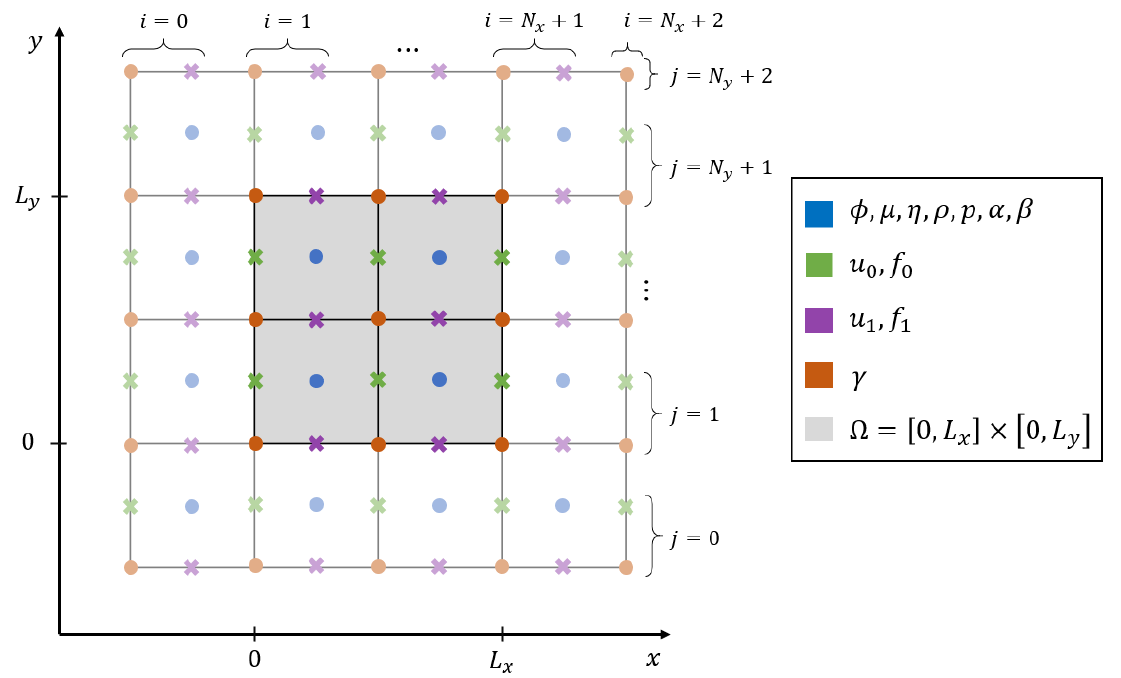
Figure 1. Staggered grid with quantities at their appropriate position. The grid is surrounded by a layer of ghost points, which are displayed slightly transparent